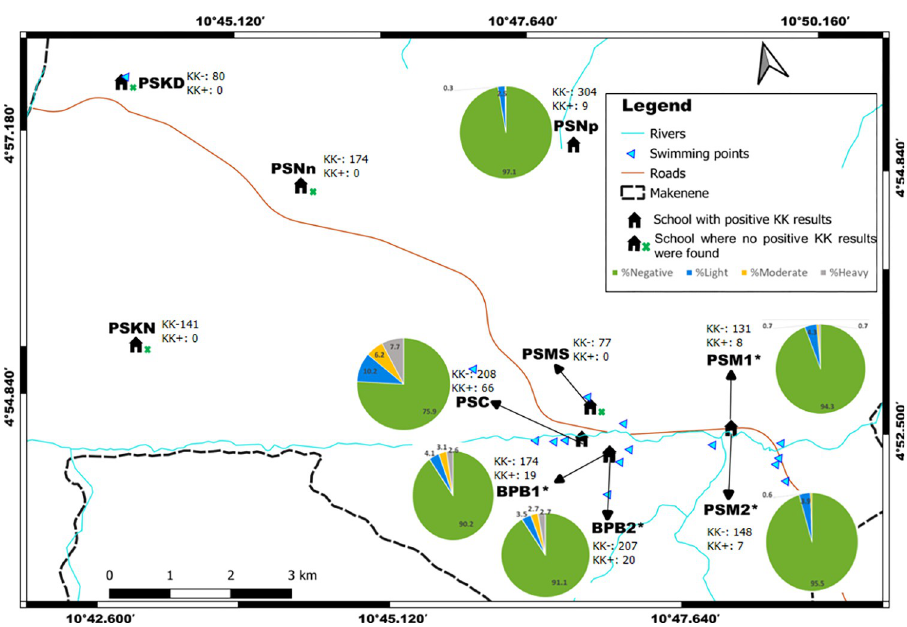
Fig 2. Distribution per school of the percentage of children with no infection or carrying different infection intensities inferred from Kato-Katz (base layer of the maps were obtained using a free online spatial data software (https://www. diva-gis.org/gdata). BPB1: Government bilingual primary school of Baloua group 1; BPB2: Government bilingual primary school of Baloua group 2; PSM1: Public school of Makenene group 1; PSM2: Public school of Makenene group 2; PSNn: Public school of Nyokon; PSKD: Public school of Kinding Nde; PSKN: Public school of Kinding Ndjabi; PSMS: Public school of Mock-Sud; PSC: Public school of Carri è re; PSNp: Public school of Ngokop, � : Schools in the same building. KK+: Number of children carrying S . mansoni eggs in each school; KK-: Number of children without S . mansoni egg in each school.